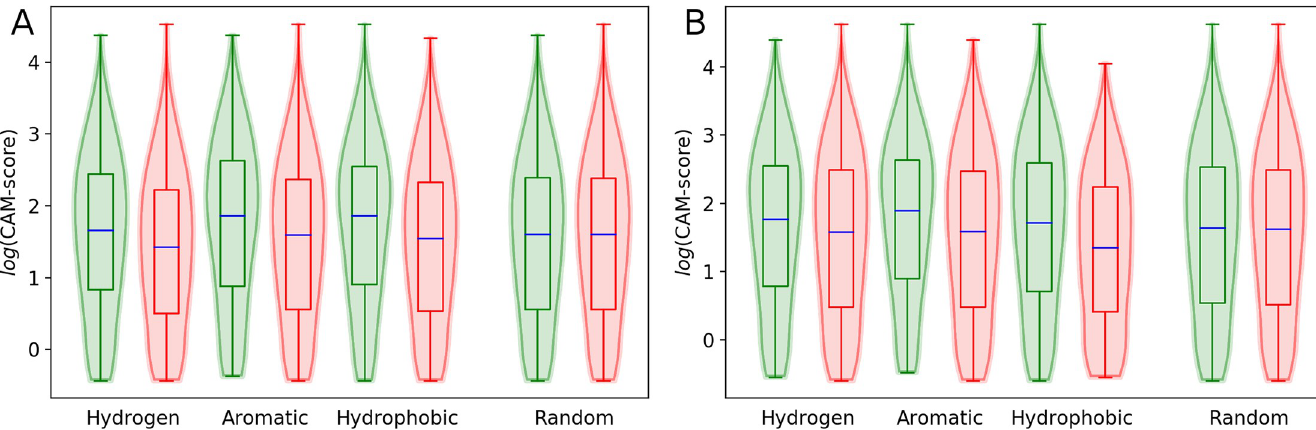
Fig 7. Distribution of class-activation map (CAM) scores for specific ligand-protein interactions. Three interaction types, hydrogen bonds, aromatic and hydrophobic contacts are reported by the LPC program for ( A ) nucleotide- and ( B ) heme-binding pockets. For each interaction type, grid points are divided into two groups, those points in close proximity to residues forming a particular contact and the remaining points that are closer to residues not forming these interactions. The last pair of violins are plotted for grid points randomly assigned into two groups, irrespectively of any ligand-protein interactions. Horizontal blue lines represent median values, and whiskers extend to the most extreme non-outlier data